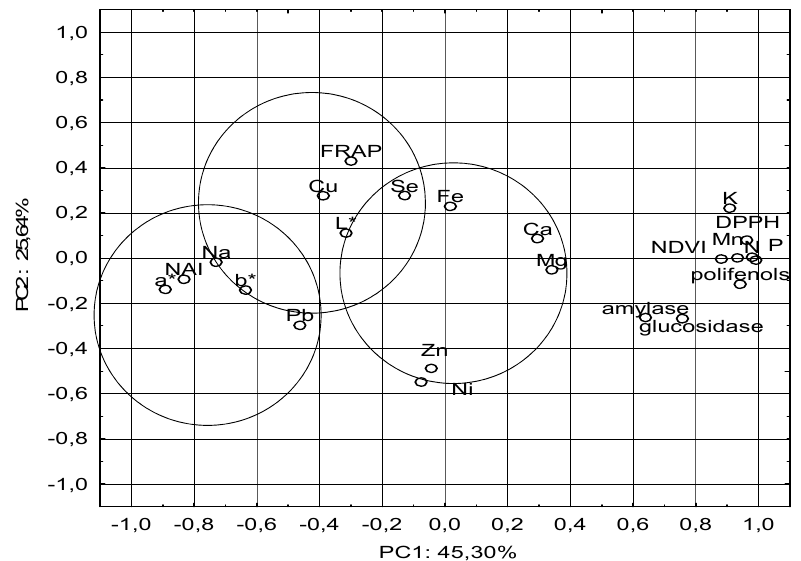
Figure 2. The principal component analysis (PCA) for mineral compositions and phytochemical content of goji leaves and fruit depending on growth conditions. of goji leaves and fruit depending on growth